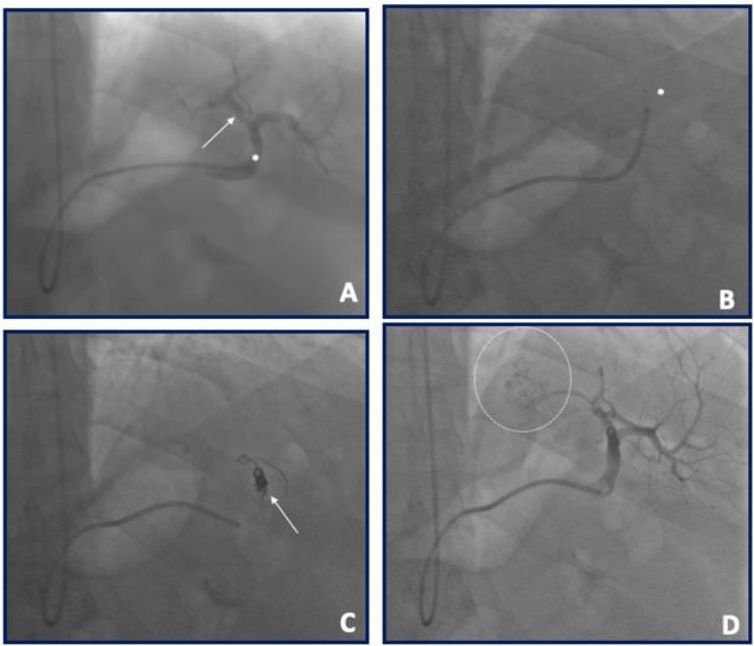
Figure 4. Case example of a left gastroepiploic artery (arrow) embolization in a 55 years old male with a BMI of 43.2. ( A ) Selective angiography by multipurpose 6F 125 cm into the splenic artery (asterisk). ( B ): A Rebar 0.27 (cid:48) microcatheter (Medtronic, Santa Rosa, CA, USA—asterisk) was advanced into the multipurpose catheter selectively engaging the gastroepiploic artery. ( C ) Three contour spirals (Medtronic, Santa Rosa, CA, USA) of different size and length (4 × 40 mm; 4 × 40 mm; 5 × 30 mm) were subsequently released (arrow). ( D ) Final angiography with target fundus zone indicated by dashed